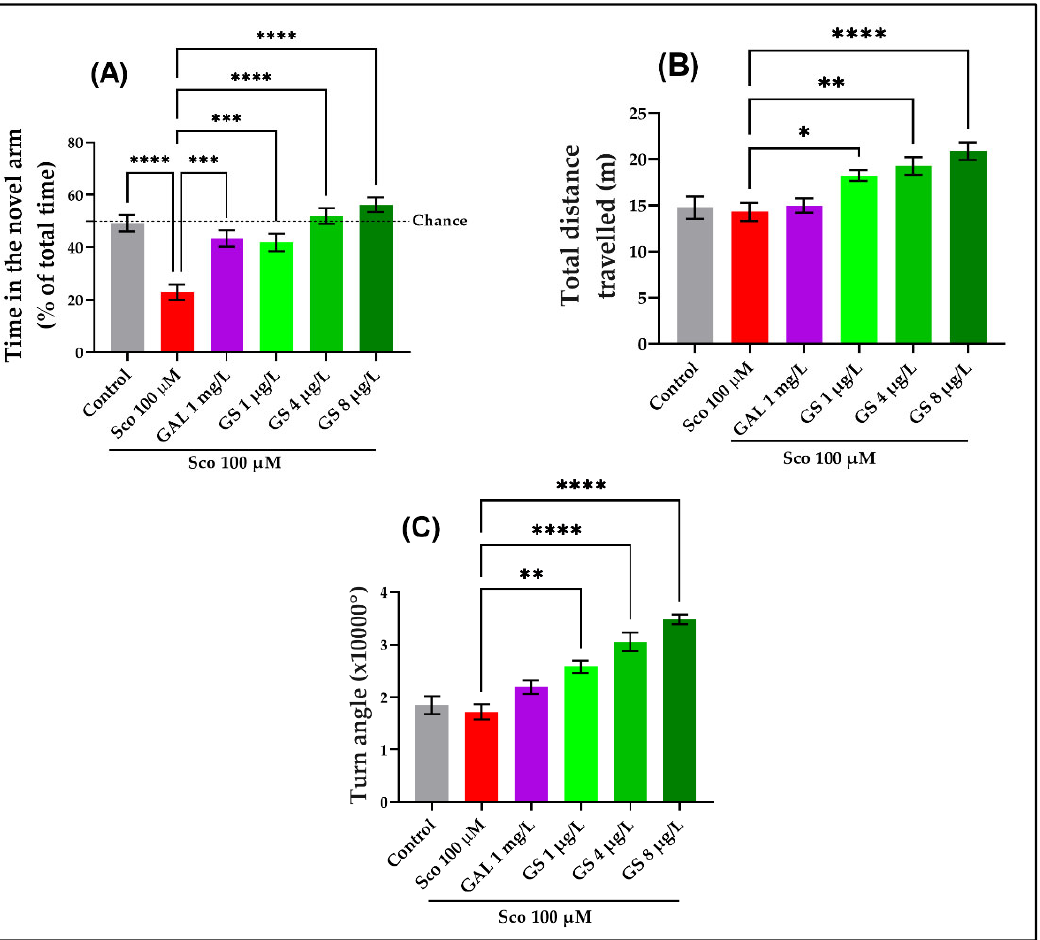
Figure 3. Guiera senegalensis hydroethanolic extract (GS: 1 μ g/L, 4 μ g/L and 8 μ g/L) improved loco ‐ motion and memory in the Y ‐ maze test. ( A ) Time spent in the novel arm. ( B ) Total distance traveled. ( C ) Turn angle. Results are expressed as mean ± S.E.M. (n = 10). For Tukey’s post hoc analyses: * p < 0.01, ** p < 0.001, *** p < 0.0001 and **** p < 0.00001.